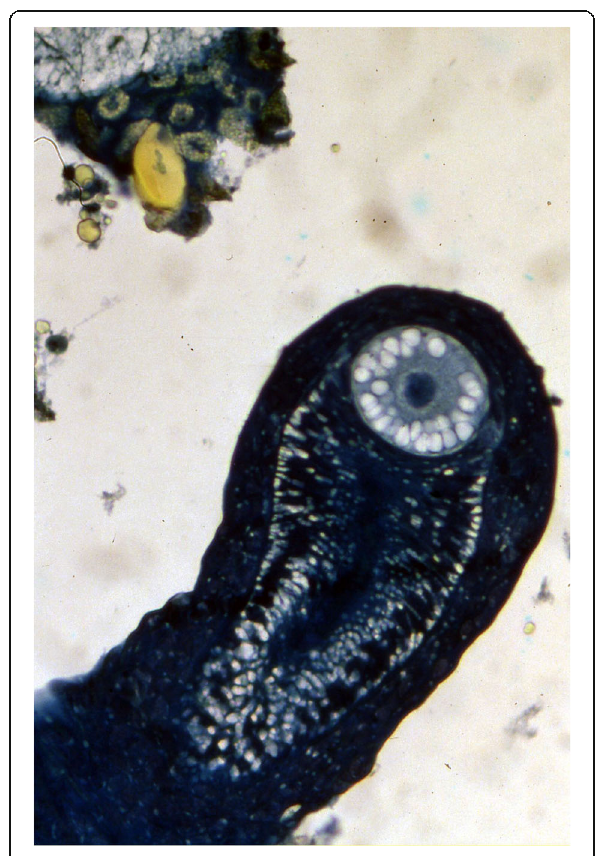
Fig. 9 Histological section showing the development of the katoikogenic hormurid Opisthacanthus asper